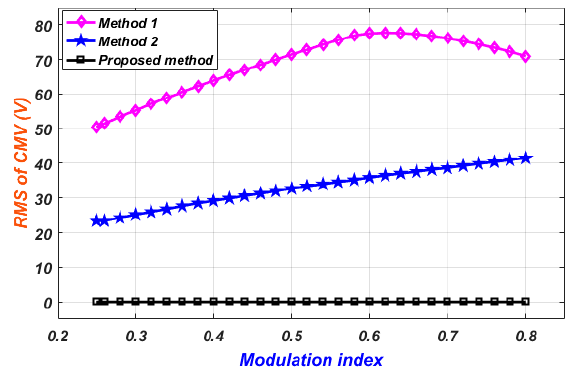
Figure 9. CMV RMS value under different modulation indexes.